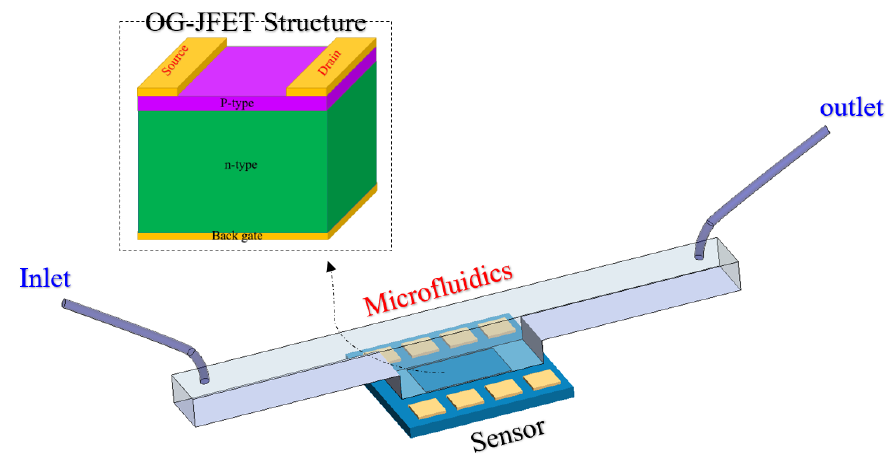
Figure 1. Schematic of OG ‐ JFET structure and the microfluidic chamber.